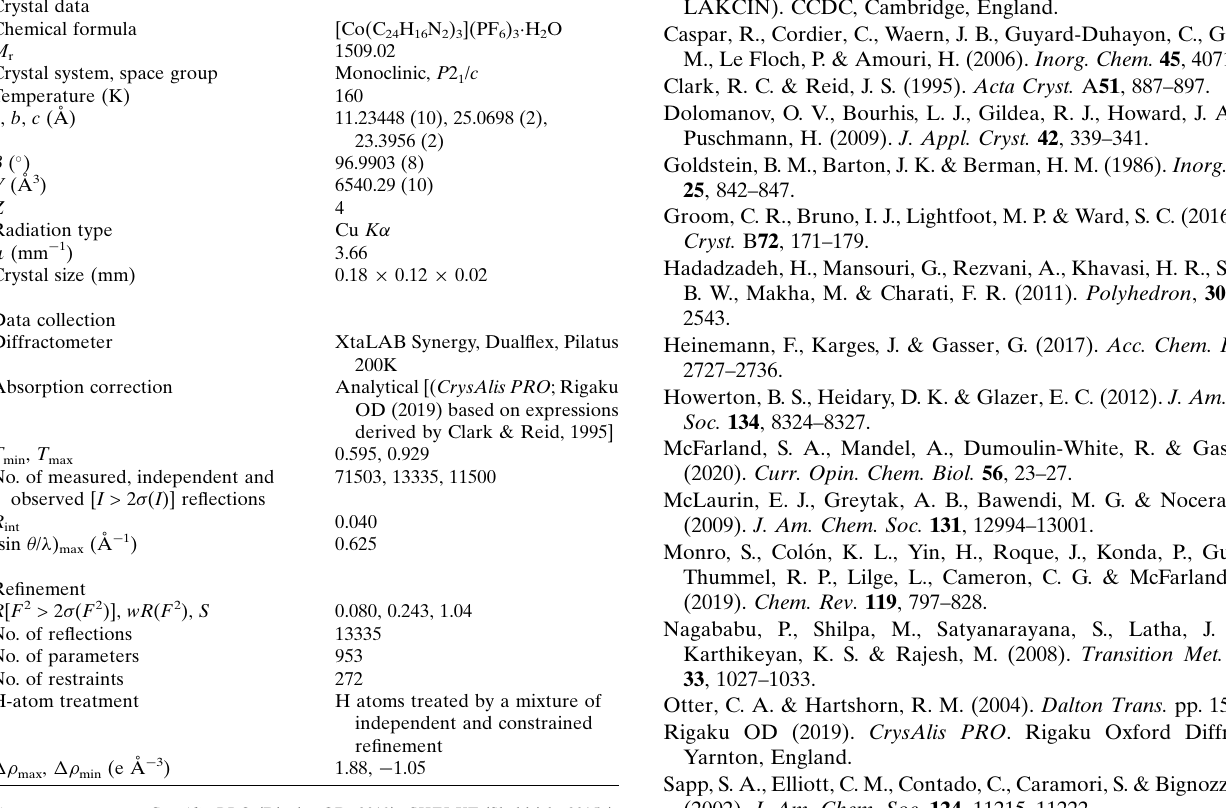
Table 3 Experimental details. Crystal data Chemical